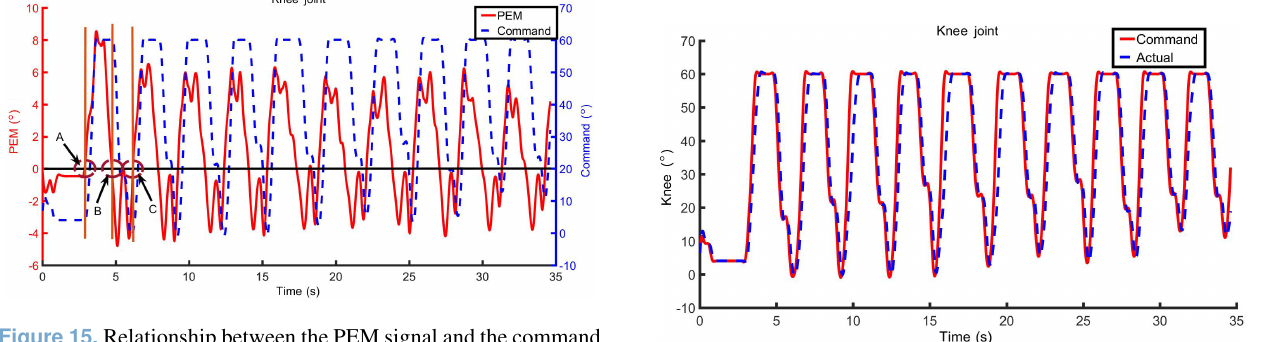
Figure 15. Relationship between the PEM signal and the command signal for the knee joint.